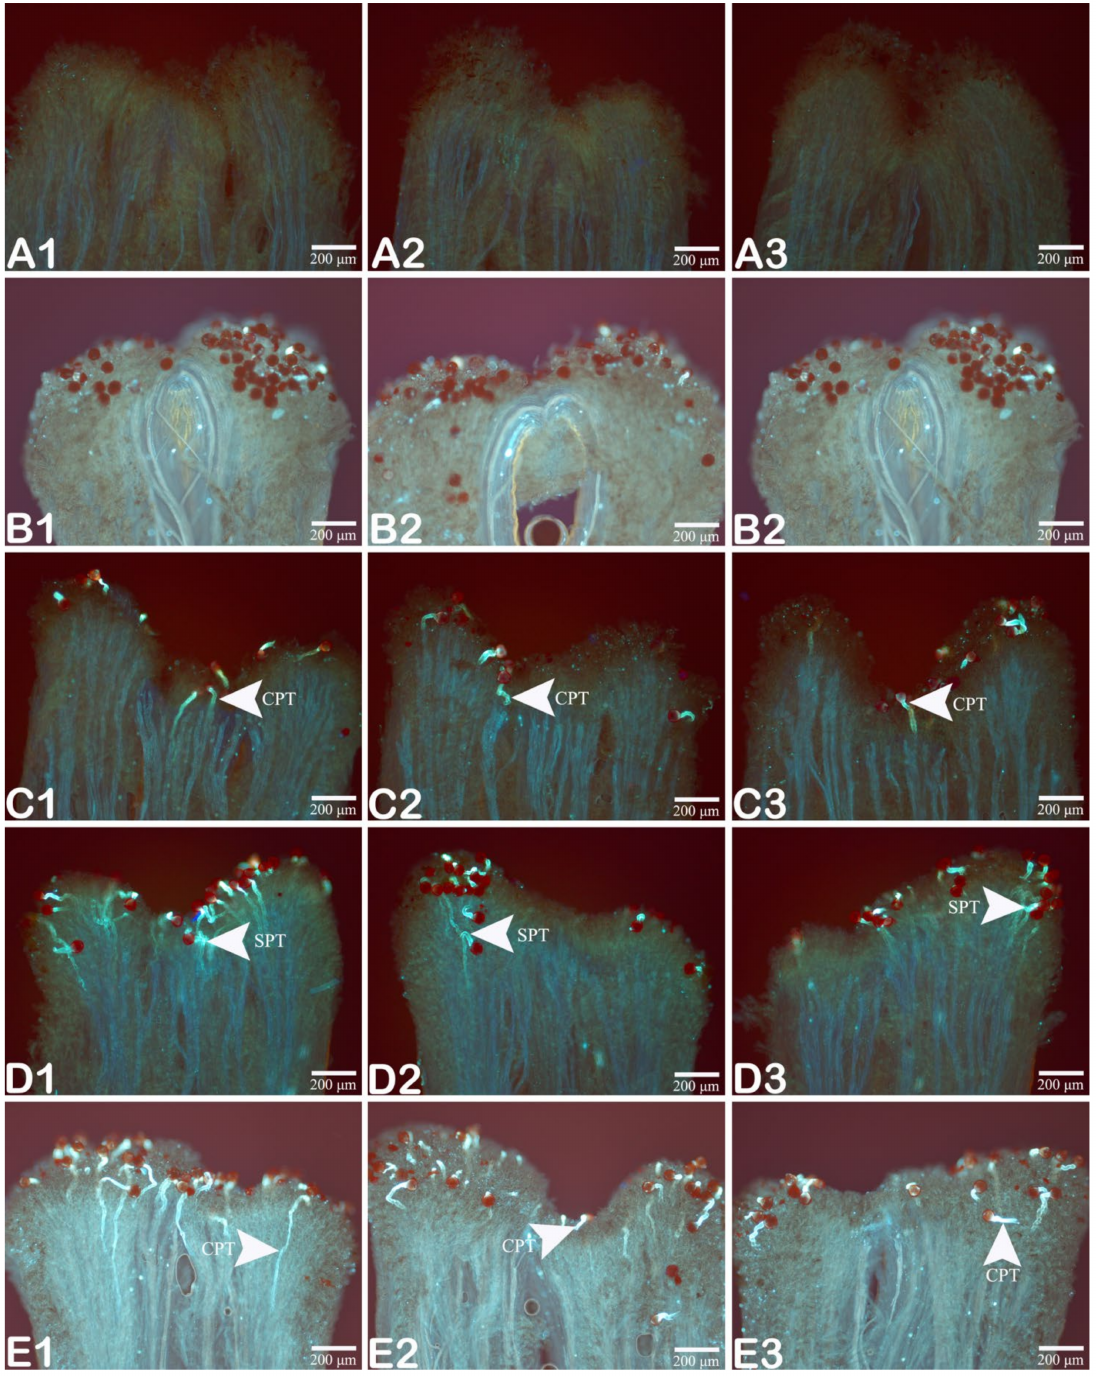
Figure 2. Pollen germination on the stigma after self-pollination and cross-pollination. ( A1 ) ‘GW1’ without pollination; ( A2 ) ‘GW2’ without pollination; ( A3 ) ‘GW3’ without pollination; ( B1 ) ‘GW1’ at 4